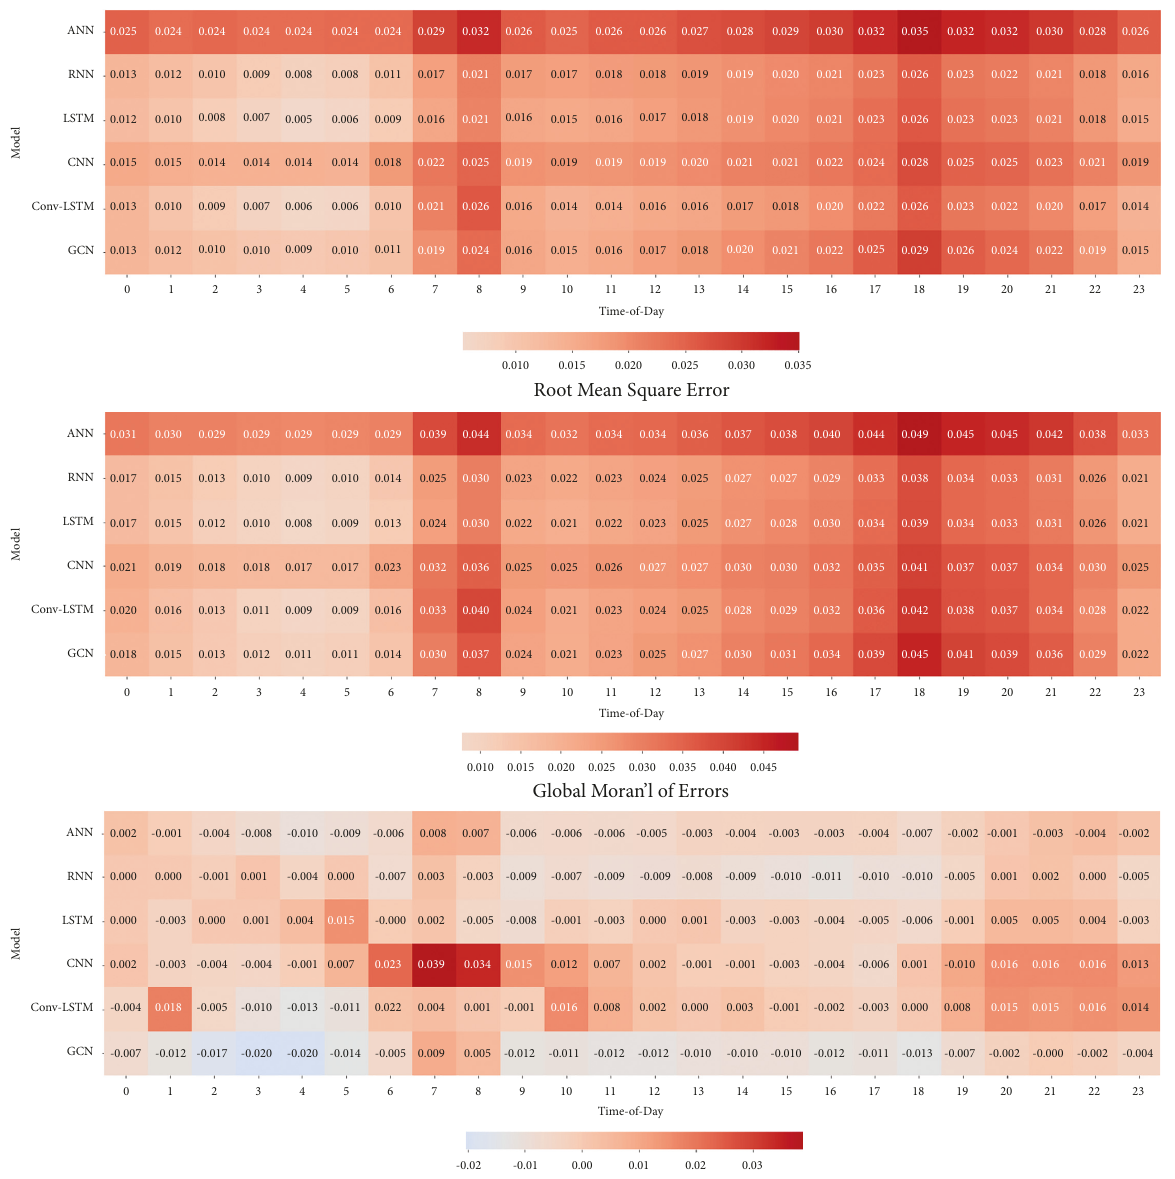
Figure 3: Performance metrics and global Moran’s I of errors for time-of-day.